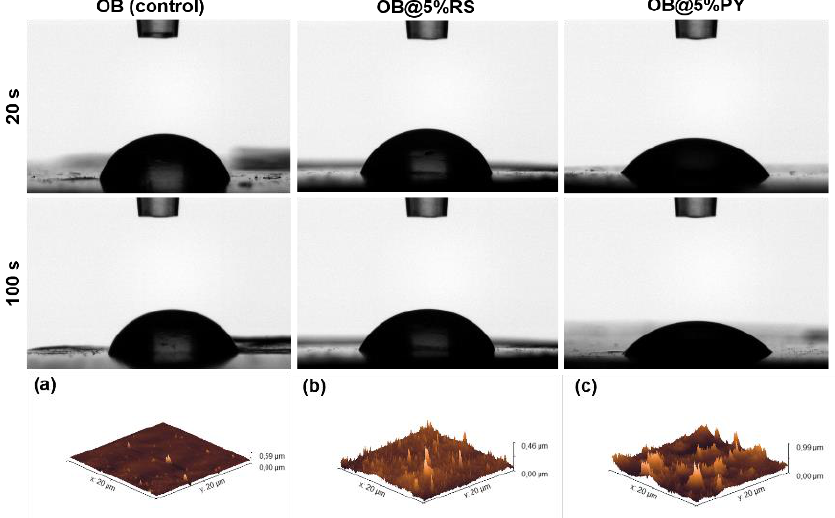
Figure 7. Contact angles of a water droplet (initial volume of 8 µ L) deposited onto different composite surfaces (OB, OB@5%RS and OB@5%PY) after 20 and 100 s post deposition. AFM micrographs (20 µ m × 20 µ m) of the different composite surfaces ( a ) OB, ( b ) OB@5%RS and ( c ) OB@5%PY.